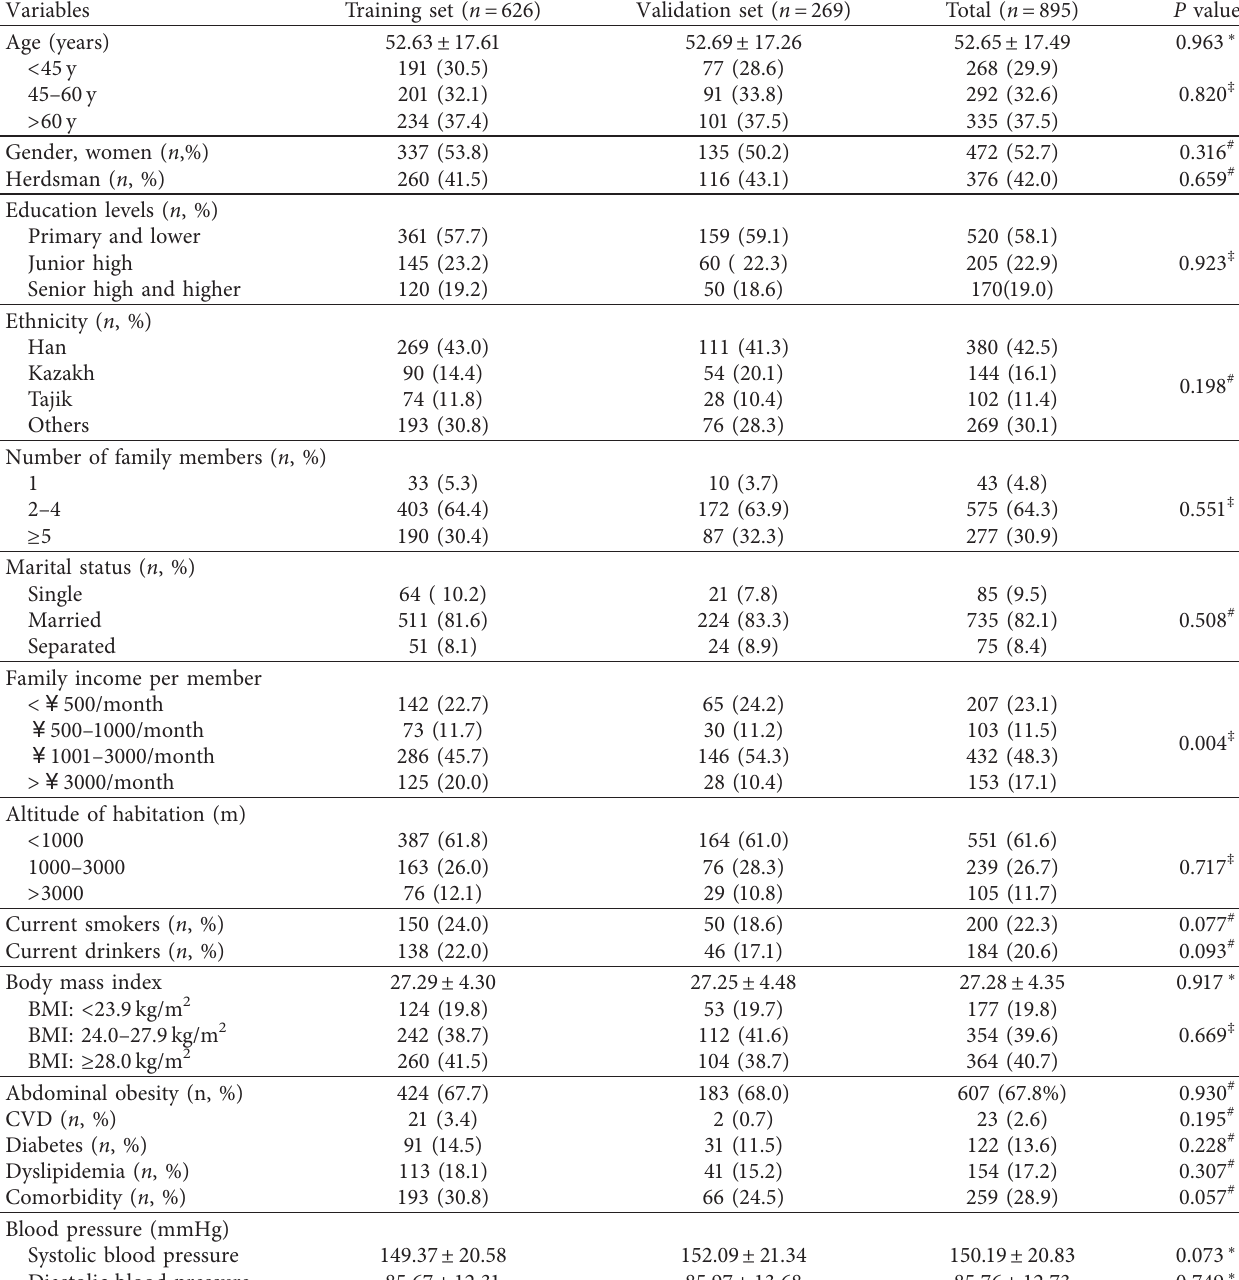
Table 1: Baseline characteristics of the study population by training set and validation